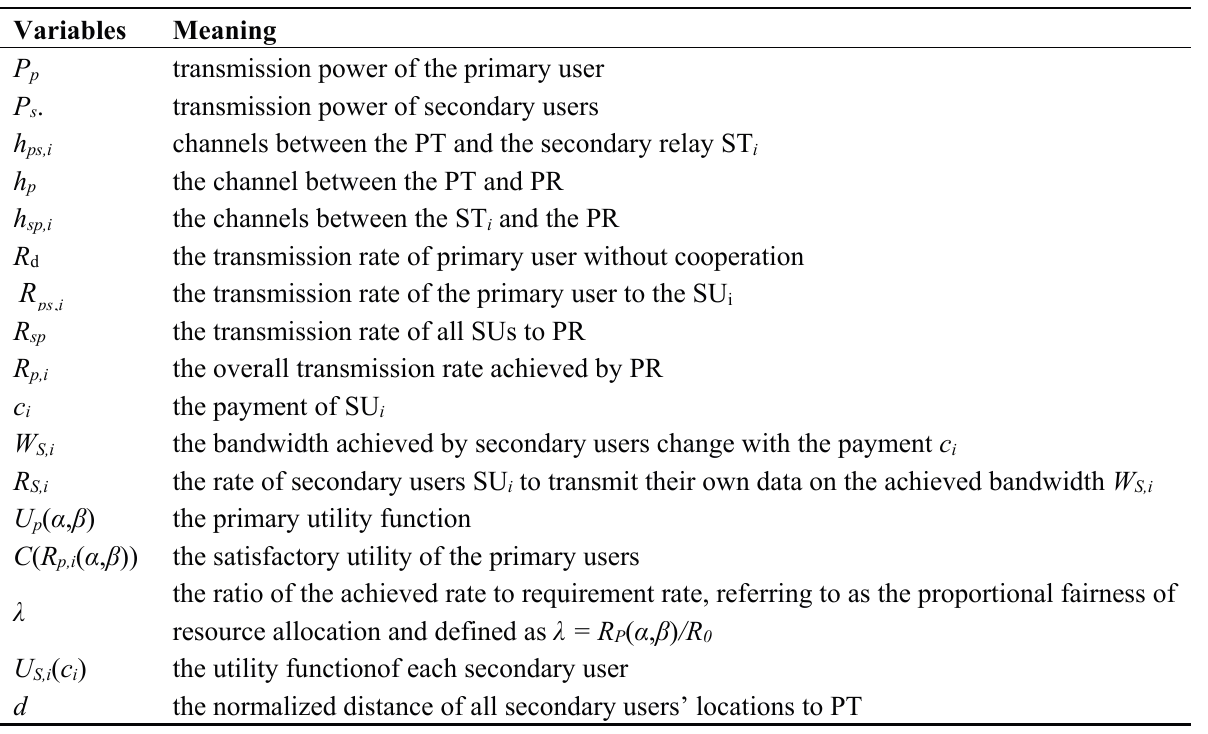
Table 1. The meanings of the